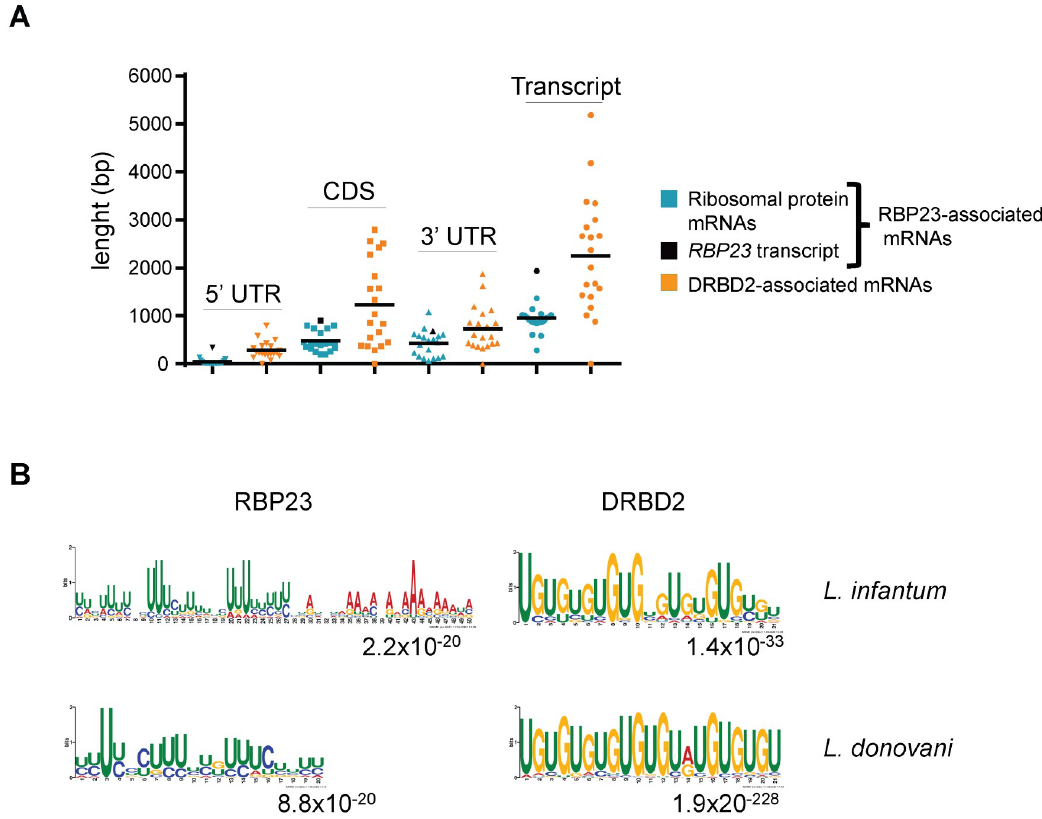
Fig 7. Sequence elements within the 3’UTRs of trypanosomatid mRNAs associated with RBP23 and DRBD2. ( A ) Comparison of RBP23 (blue) and DRBD2 (orange) 5’ ( ▼ ) and 3’ ( ▲ ) UTRs, CDS ( & ) and total transcript lengths ( ● ) according to L . donovani orthologous sequences [48]. The mean values are represented by black lines and the RBP23 transcript is indicated by the same symbols coloured in black. ( B ) Putative motifs found within 3’UTRs from the top 20 mRNAs associated to either HA-tagged RBP23 or DRBD2 in L . infantum and L . donovani . The motifs found in searches with mRNAs enriched with the HA-tagged RBP23, including the RBP23 transcript as well as the top 19 mRNAs encoding ribosomal proteins, are shown on the left. Those motifs found for the top 20 mRNAs associated to HA-tagged DRBD2 are shown on the right. All logos were generated by MEME ( Multiple Em for Motif Elicitation ) and the relative height of each nucleotide represents the conservation at that specific position. The e-values are in the right corner of each